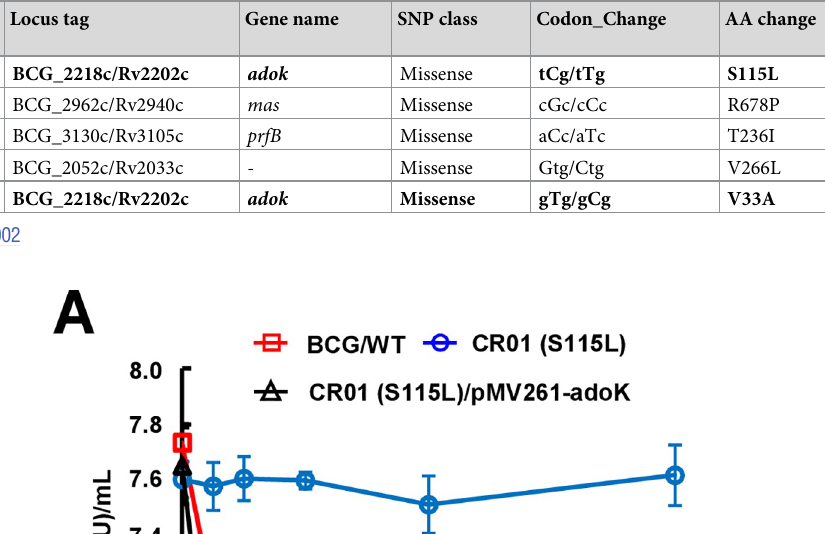
Table 2. Single nucleotide polymorphisms identified in the Mycobacterium bovis BCG isolates.